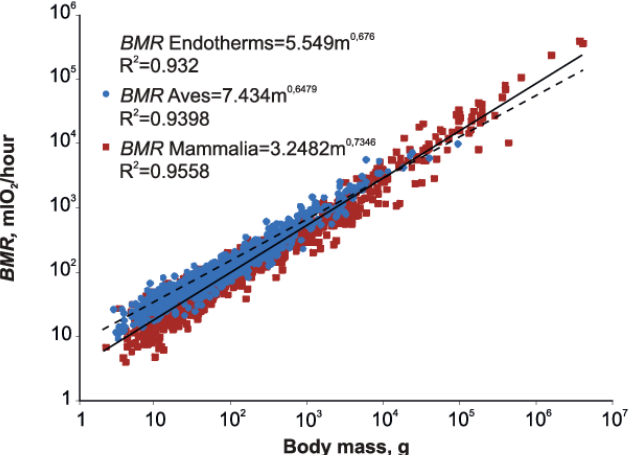
Figure 1. BMR as function of body mass in all endotherms and in mammals and birds separately. Solid line—mammals, dotted line—birds.